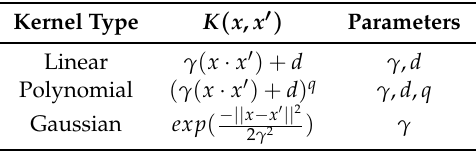
Table 1. Most used kernels for kernel transformation.